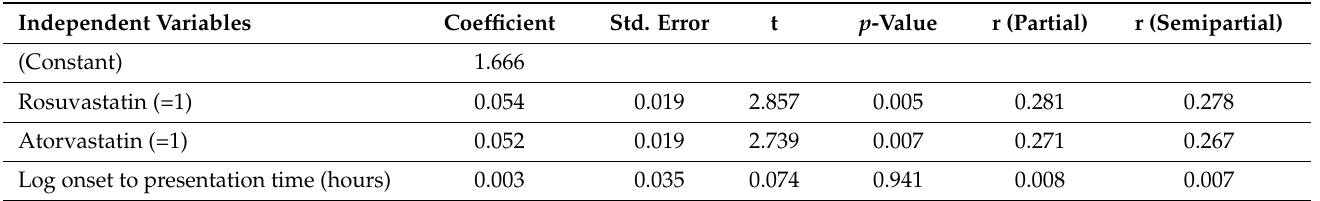
Table 3. Multivariable linear regression analysis for effect of rosuvastatin or atorvastatin on the LVEF at hospital discharge as adjusted for onset to presentation